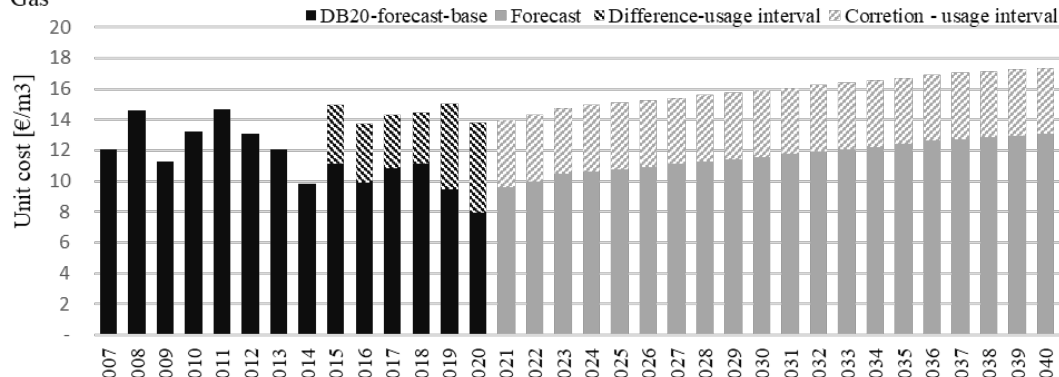
Figure 6. Historic (black) and forecasted (grey) values for electricity and gas. Diagonally filled pattern represents the unit cost difference for relevant usage intervals. Forecasted values are corrected for the applied usage interval in the simulations.